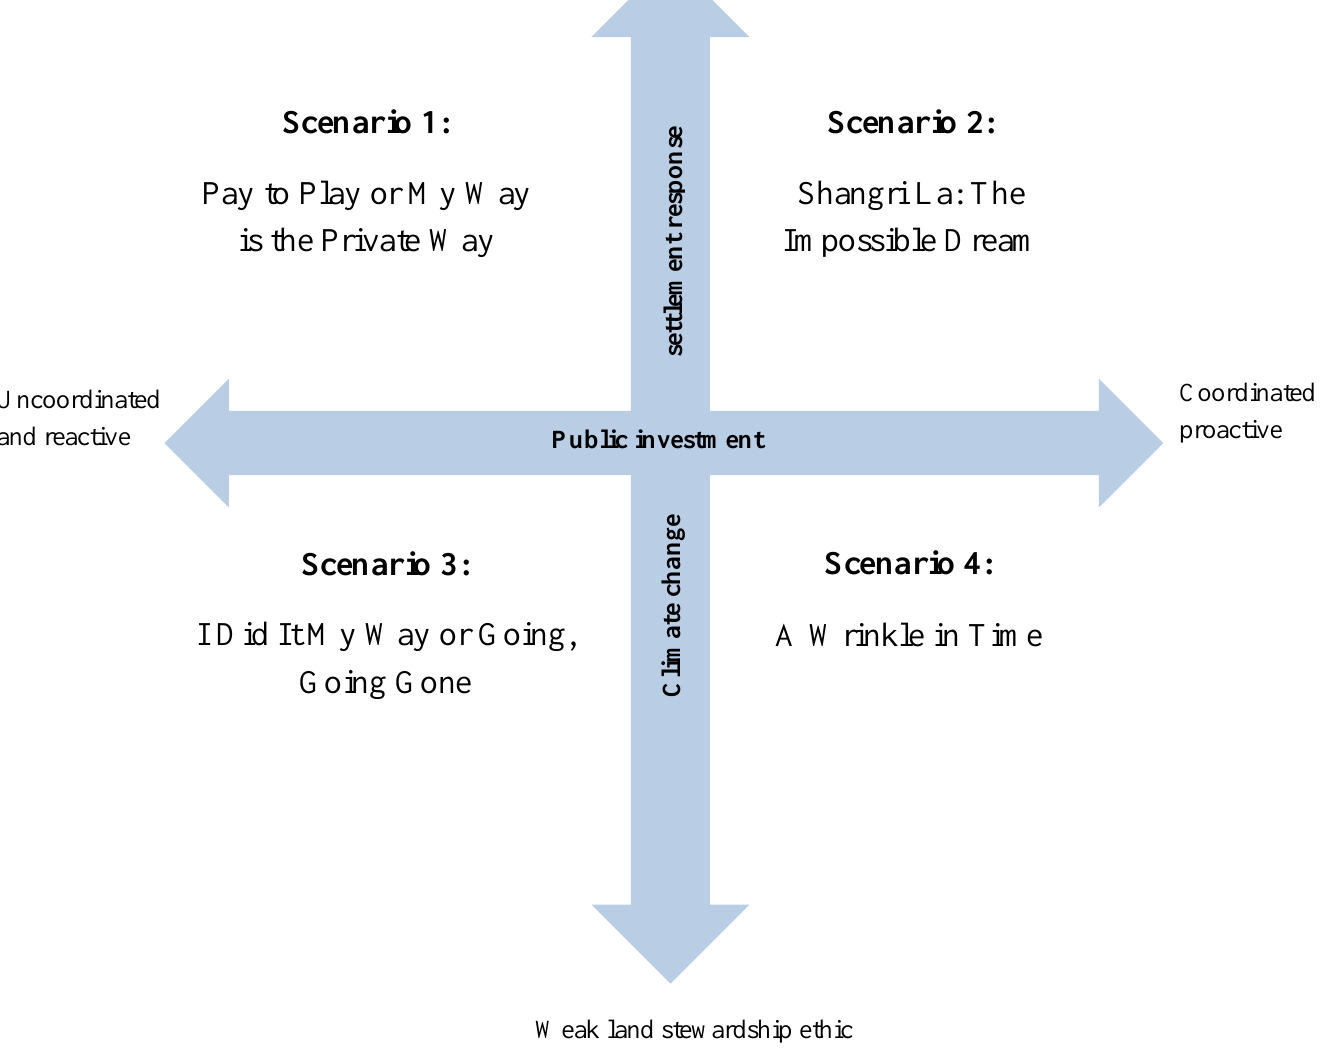
Fig. A2.5. Rhode Island scenario